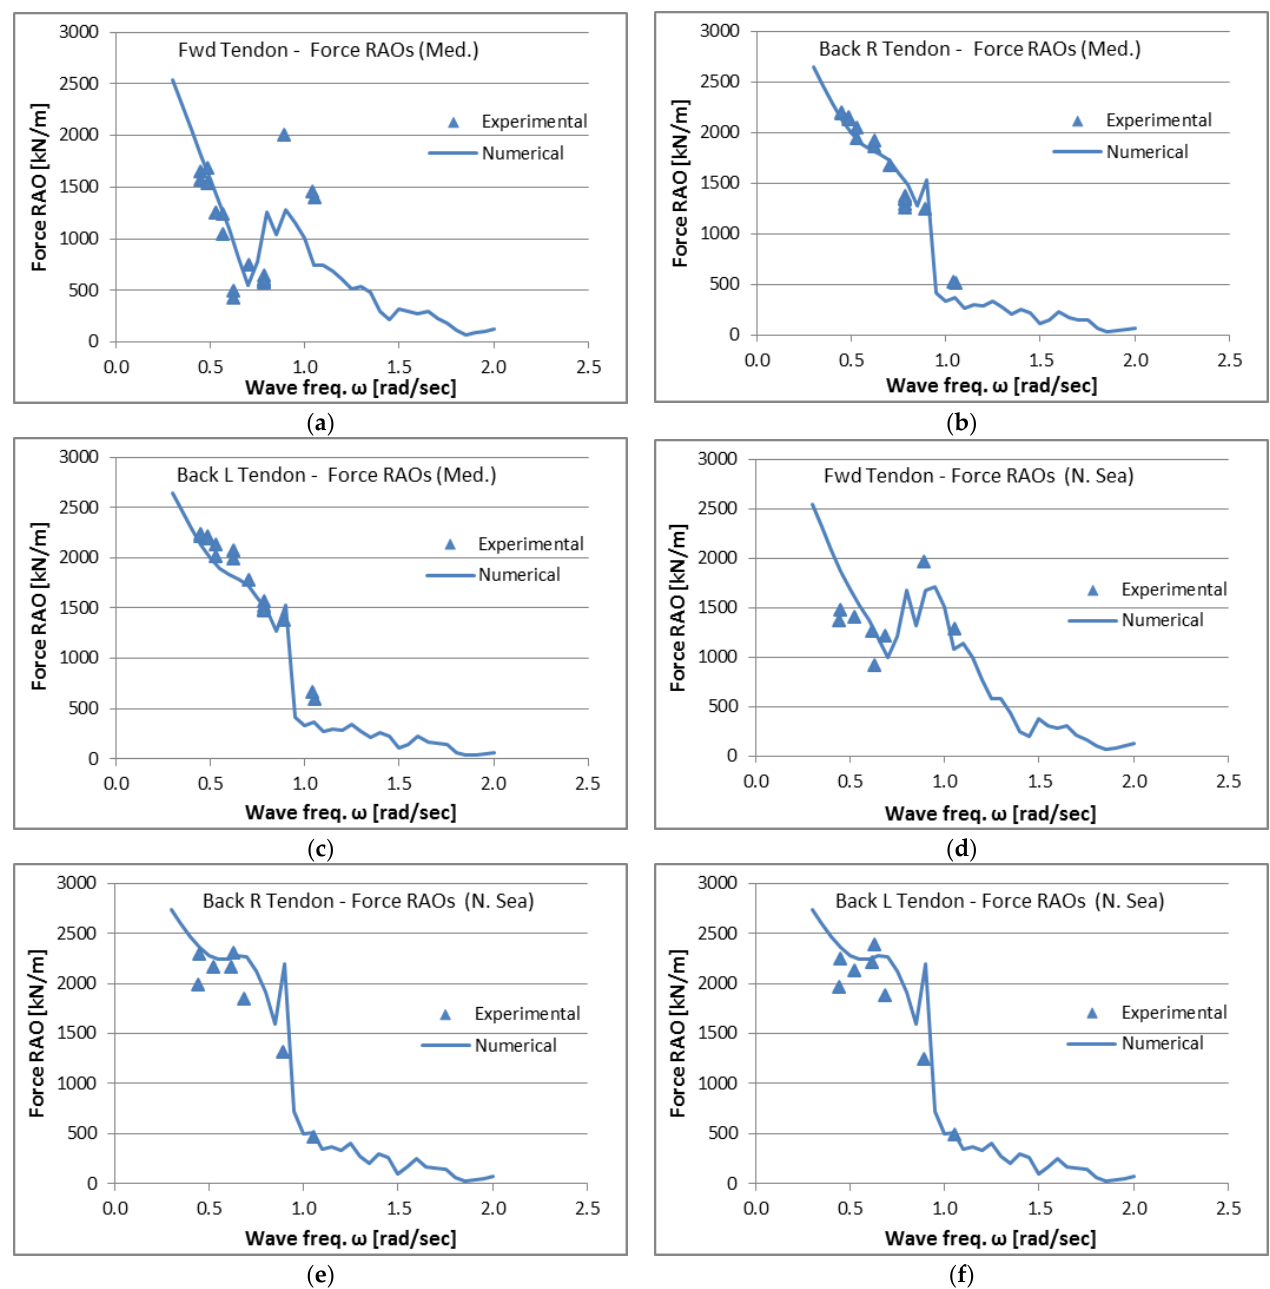
Figure 11. REFOS mooring tensions comparisons: ( a ) forward tendon for the Mediterranean Sea location; ( b ) backward right tendon for the Mediterranean Sea location; ( c ) backward left tendon for the Mediterranean Sea location; ( d ) forward tendon for the North Sea location; ( e ) backward right tendon for the North Sea location; ( f ) backward left tendon for the North Sea location.